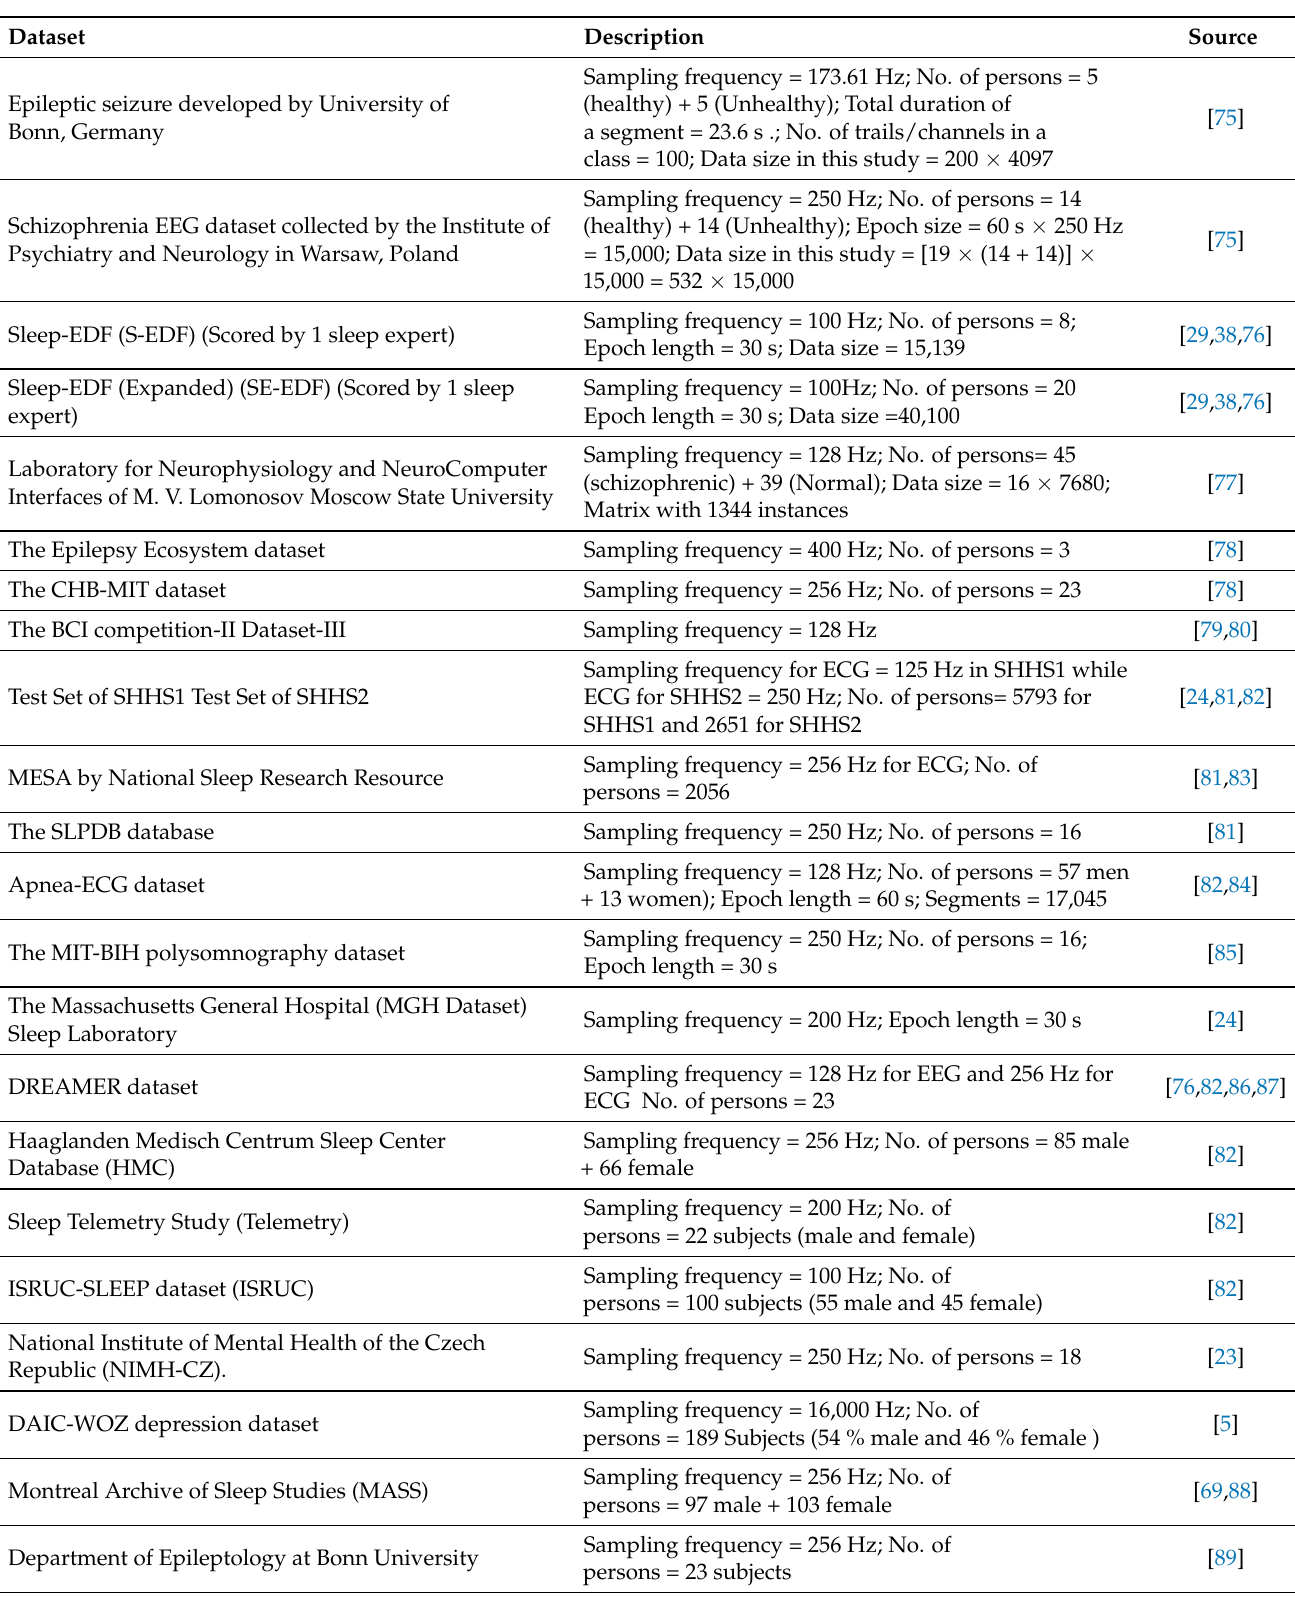
Table 2. A summary of open-access PSG datasets. We presented basic information used by previous research in this field of